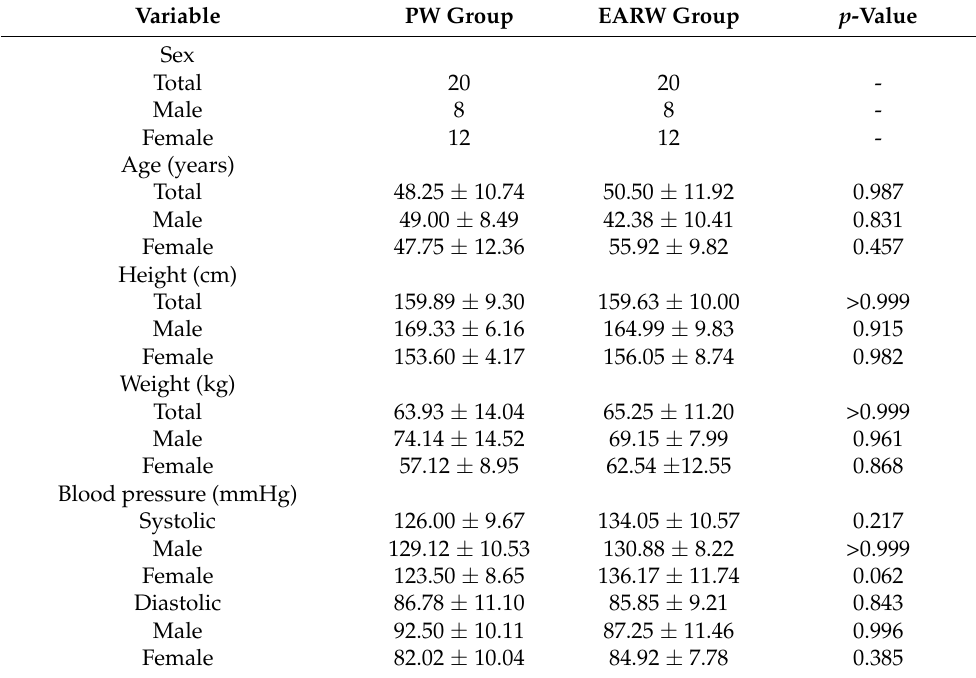
Table 2. Baseline characteristics of participants.